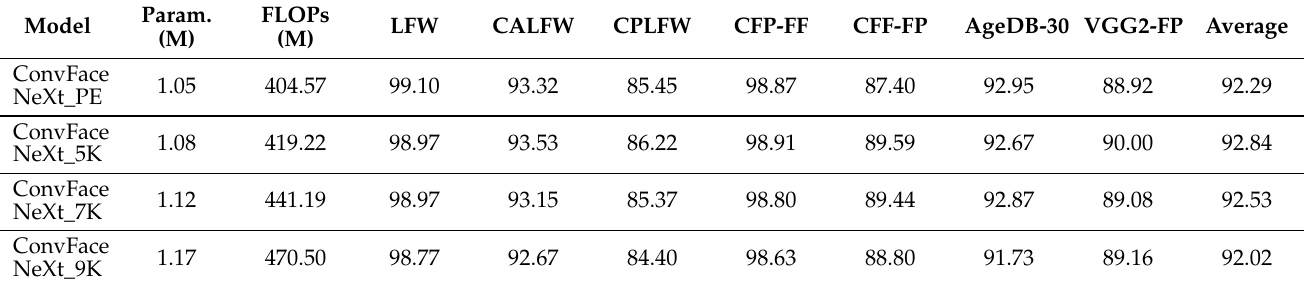
Table 6. Performance results of different kernel sizes. These results are reported in terms of pa- rameters, FLOPs and verification accuracy for LFW, CALFW, CPLFW, CFP-FF, CFP-FP, AgeDB-30 and VGG-2FP. That aside, the average accuracy for the seven image-based datasets is shown in the last column. Here, the first row represents a model with a kernel size of three in the depthwise convolution of the ECN block, ‘5K’ refers to a kernel size of five, ‘7K’ refers to a kernel size of 7, and ‘9K’ refers to kernel size of nine.